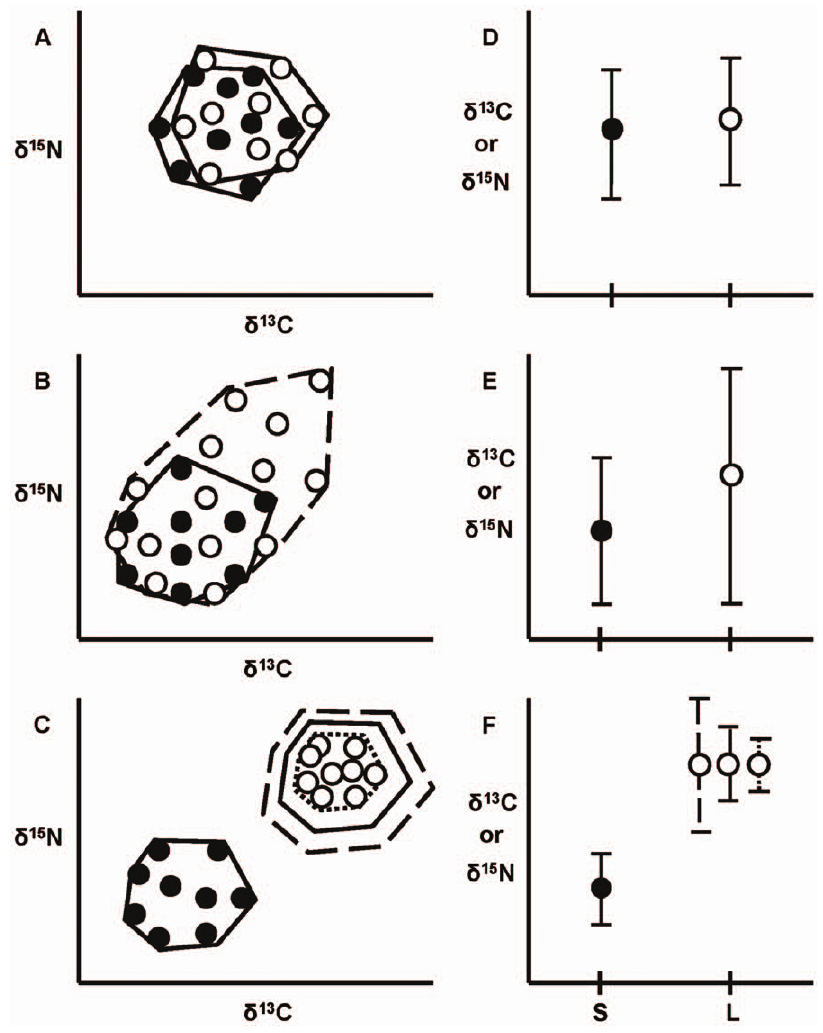
Figure 1. Representation of three possible ontogenetic niche shift scenarios using stable isotope ratios. Horizontally adjacent panels represent the same ontogenetic niche shift scenario. (A–C) Multivariate illustration of potential differences in niche width (represented by convex hull polygons), niche position and niche overlap (see text for more details) between two size classes in d 13 C- d 15 N niche space. (D–F) Univariate representation of niche width (variance of isotope values) and niche position (mean isotopic value) of either d 13 C or d 15 N between size classes. Closed circles represent isotope data of small individuals and open circles of large individuals. For B & E, this could also be a niche reduction, i.e., small individuals would occupy larger niche width than large individuals. Solid line = constant niche width, dotted line = niche reduction, dashed line = niche expansion; S = small size class, L = large size class. In panel F, solid line = constant variance, dotted line = reduced variance, dashed line = increased variance.